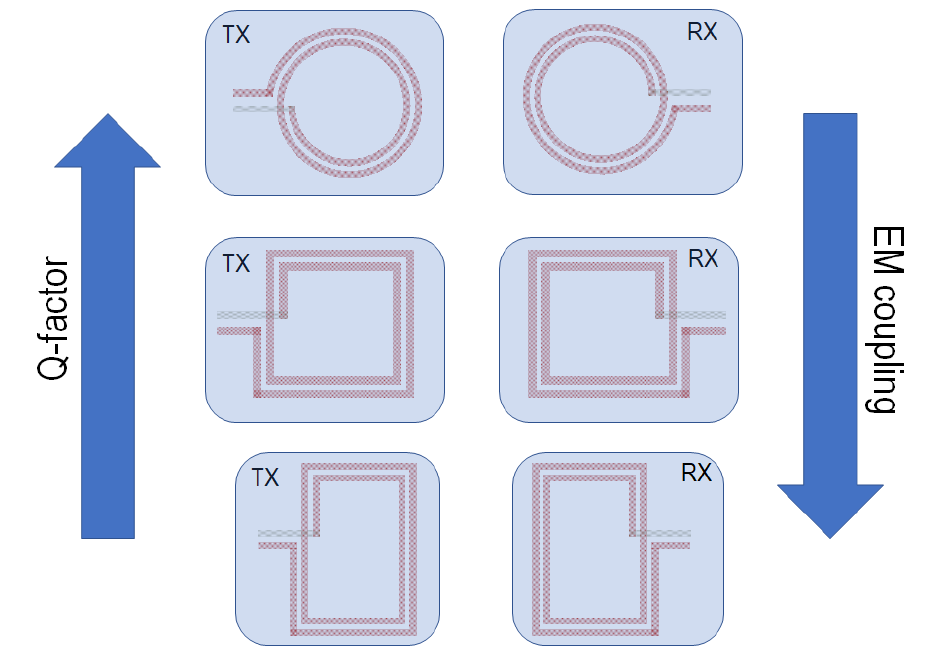
Figure 9. Micro-antenna shape optimization.